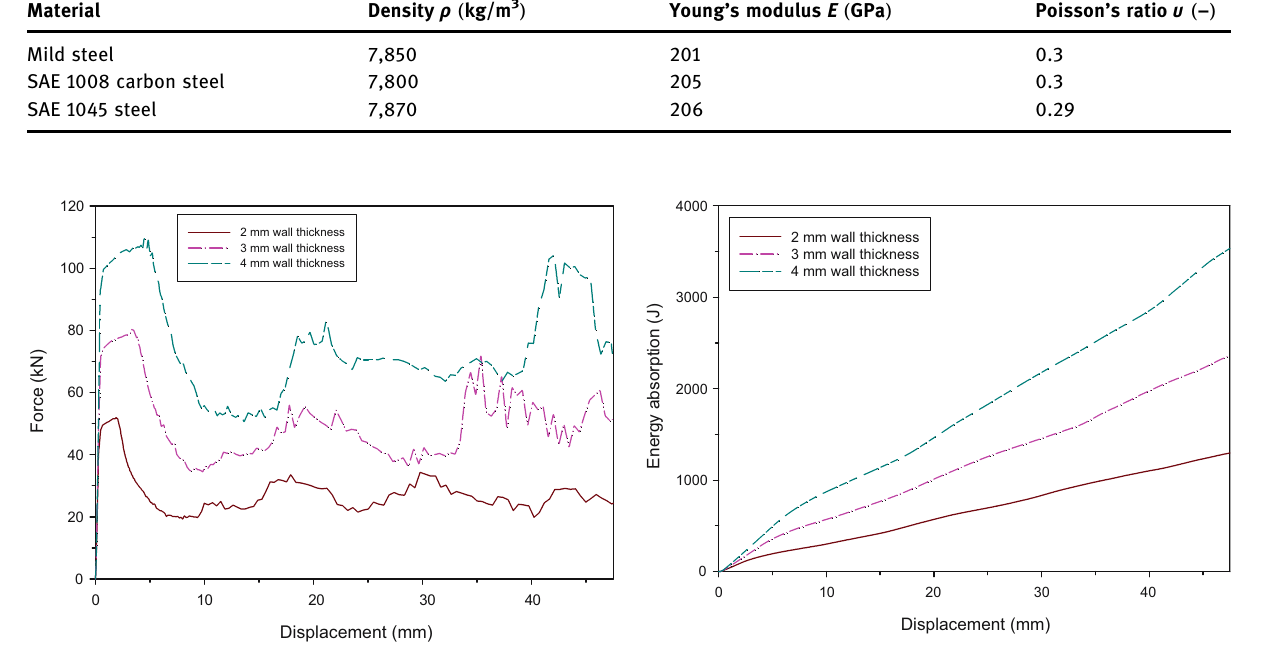
Figure 13: Energy absorption generated during axial loading with three di ff erent wall